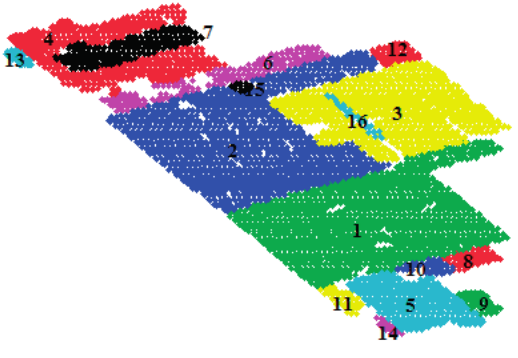
Figure 5. Segmented building roof patches with marked patch numbers.